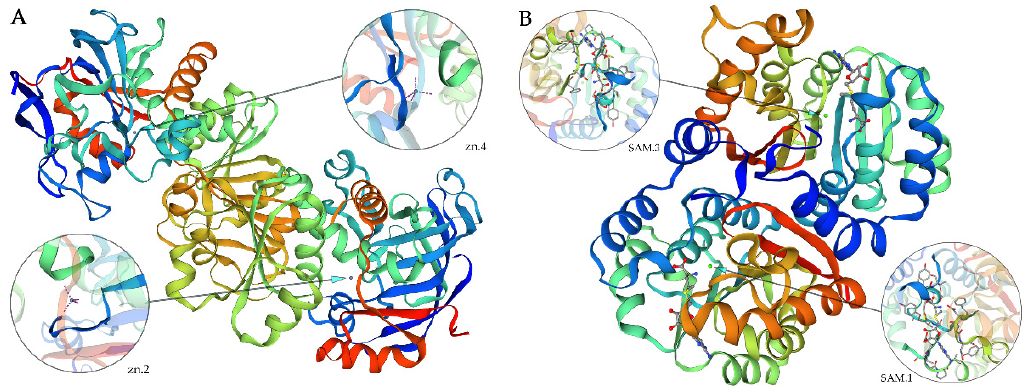
Figure 3. Homology modeling of CCoAOMT2 ( A ) and CAD5 ( B ) encoding proteins.